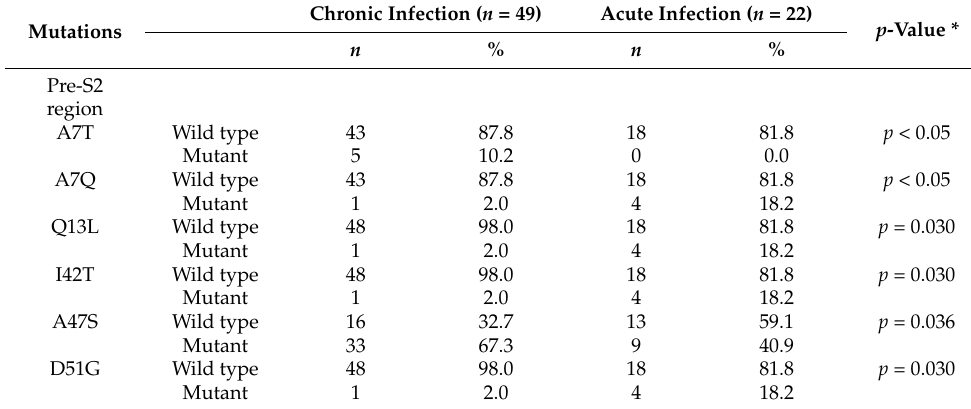
Table 4. Analysis of amino acid substitution in the pre-S2 region.